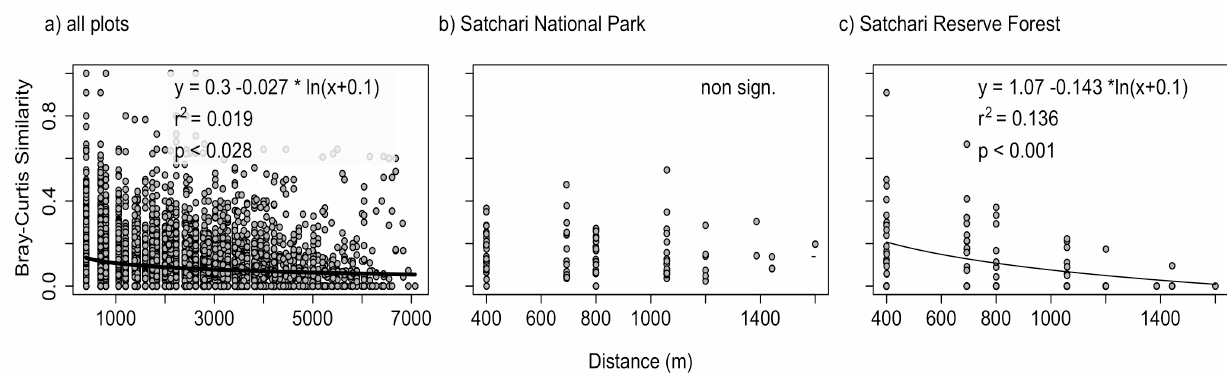
Figure 4. ( a ) Decline in similarity of tree species species composition between compared pairs of plots with distance in the whole study area. If the National Park and the Reserve Forest are considered separately, the slope of the distance-decay relationship is less steep in the National park ( b ) compared to the Reserve Forest ( c